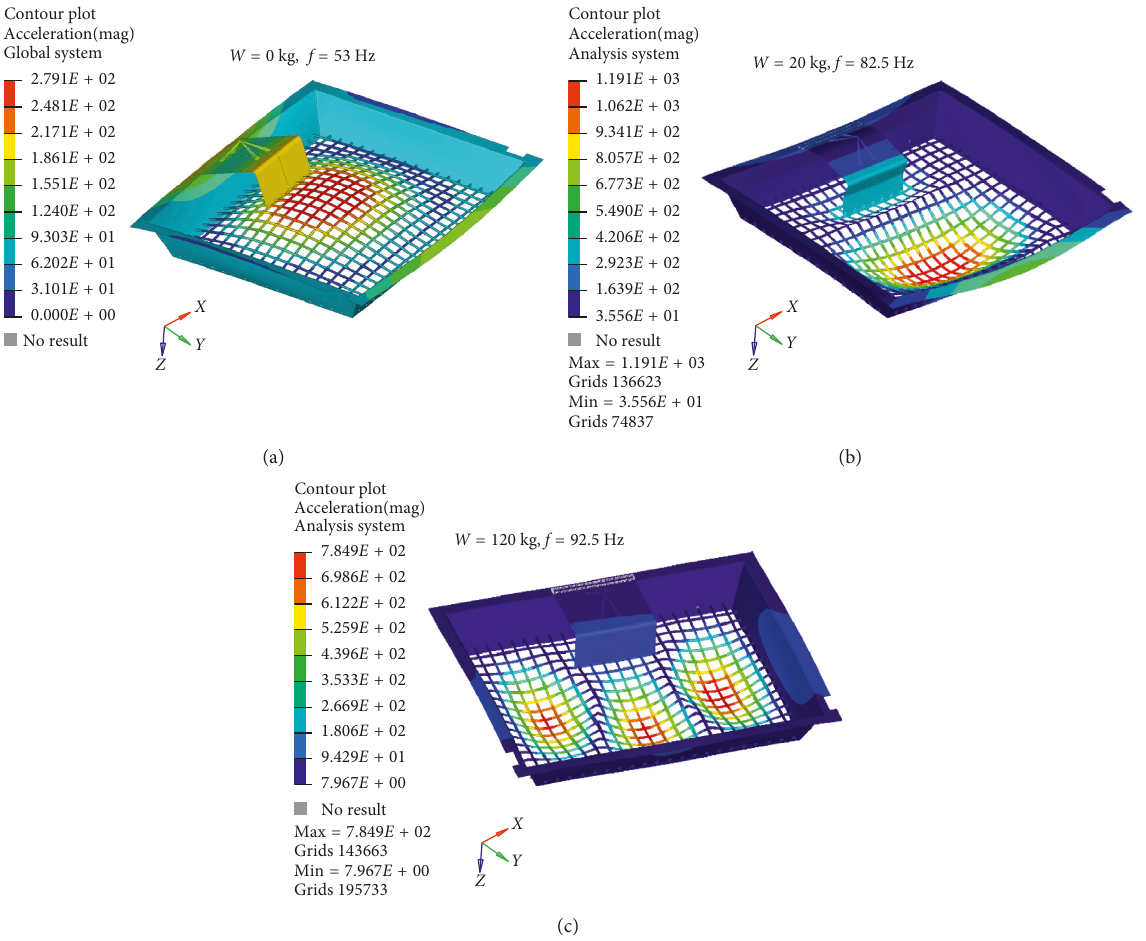
Figure 9: Typical vibrating shapes of the three paths: (a) overall concave of path 1; (b) double concave of path 2; (c) triple concave of path